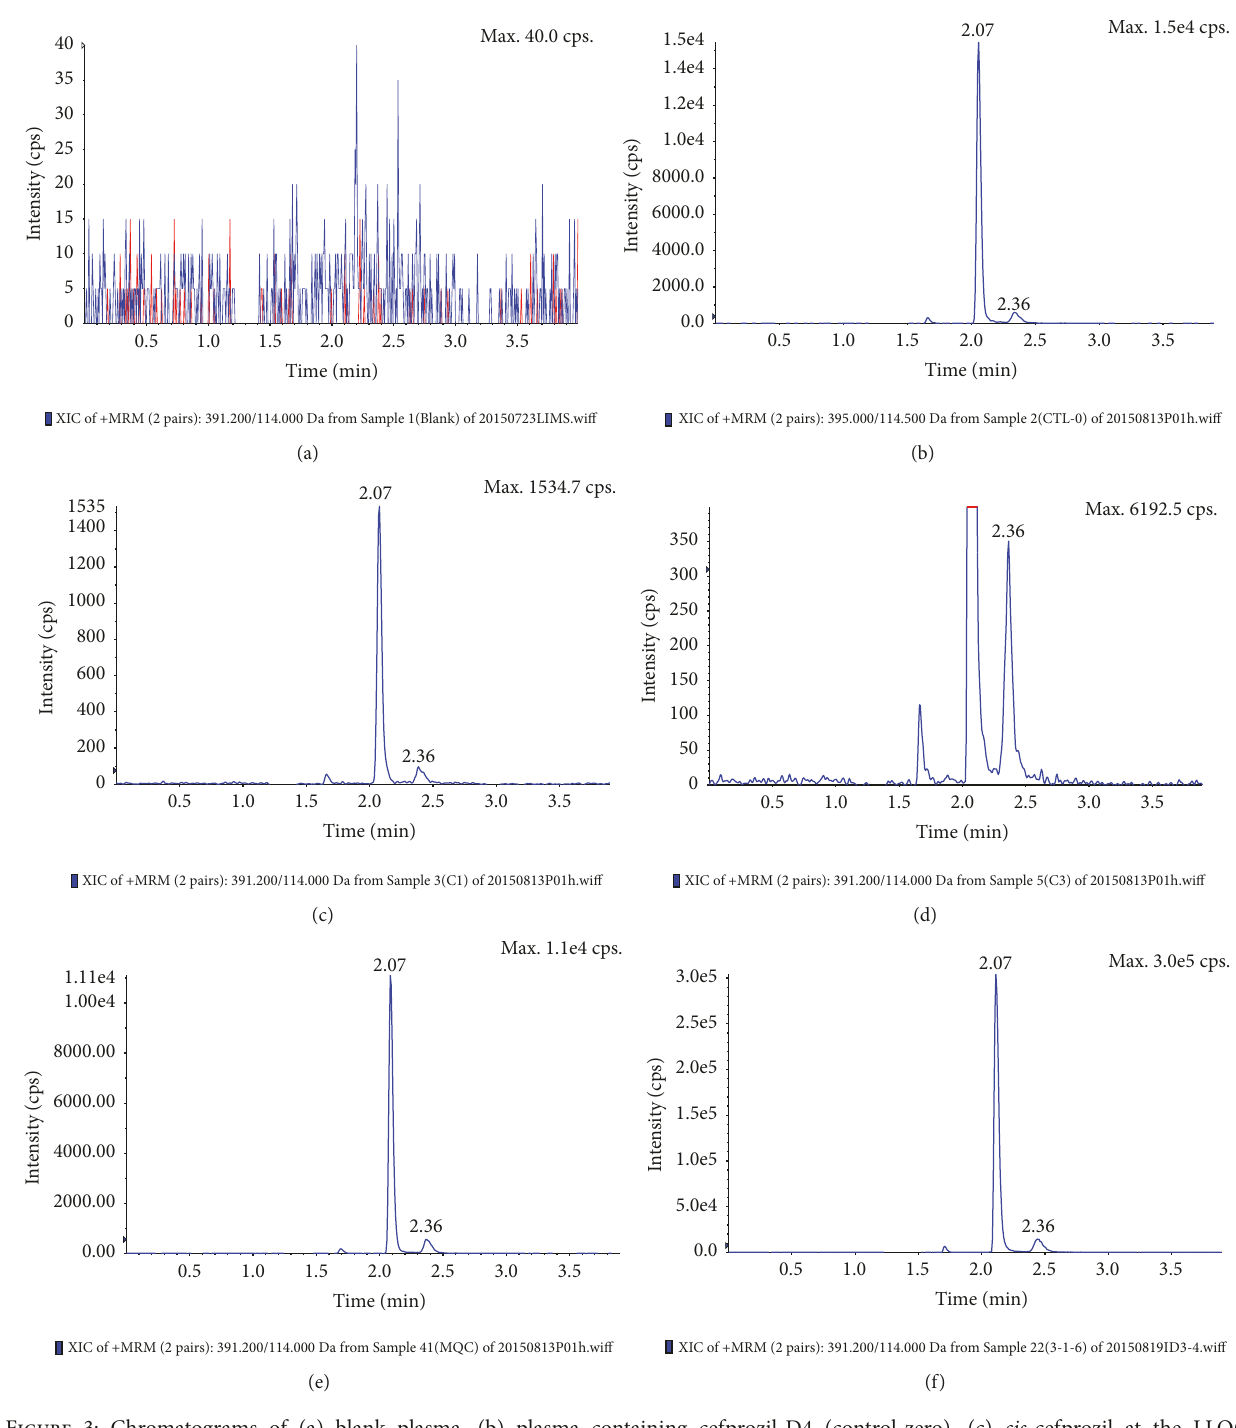
Figure 3: Chromatograms of (a) blank plasma, (b) plasma containing cefprozil-D4 (control-zero), (c) cis -cefprozil at the LLOQ (0.025 𝜇 g/mL), (d) trans -cefprozil at the LLOQ (0.014 𝜇 g/mL), (e) cefprozil at the moderate QC level ( trans -cefprozil at 0.445 𝜇 g/mL and cis -cefprozil at 4.1 𝜇 g/mL), and (f) a plasma sample from a healthy Chinese volunteer (1.5 h after dosing).